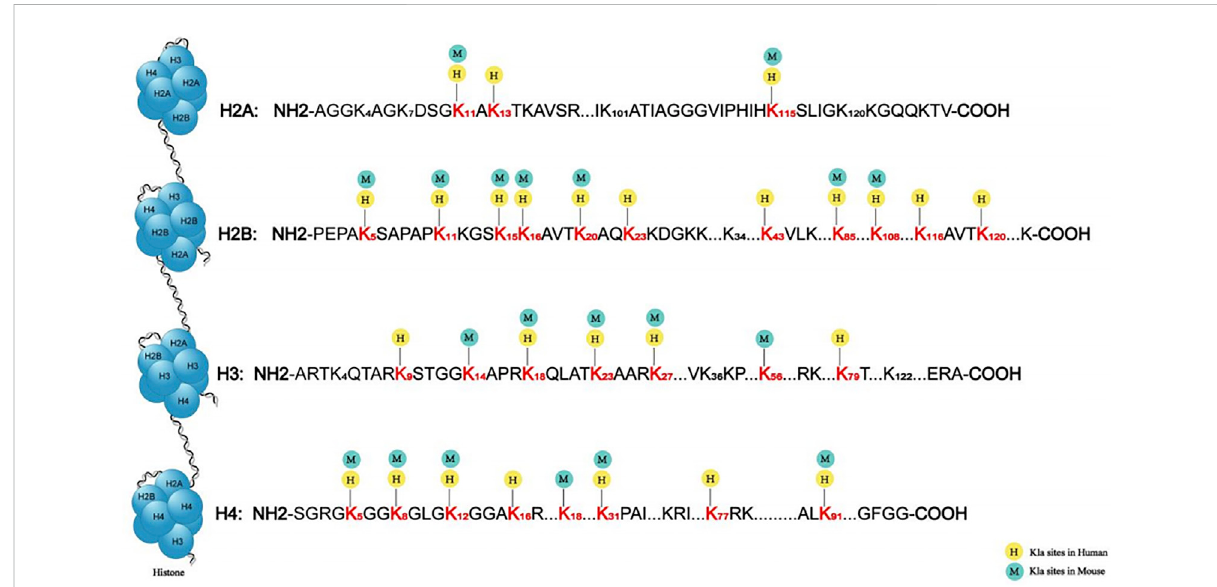
FIGURE 2 Sites of histone lactylation in humans and mice. The lactylation sites identi fi ed on the four core histones, namely, H3, H4, H2A, and H2B. The differentnumbers represent thevarioussequences of lysine inhistones. Some sites, such as H3K18, locate inboth humans and mice, shown by both yellowcircleiconwith “ H ” andgreencircleiconwith “ M ” .Otherslocateinonlyhumansormice,shownbyyellowcircleiconwith “ H ” andgreencircle icon with “ M ” ,